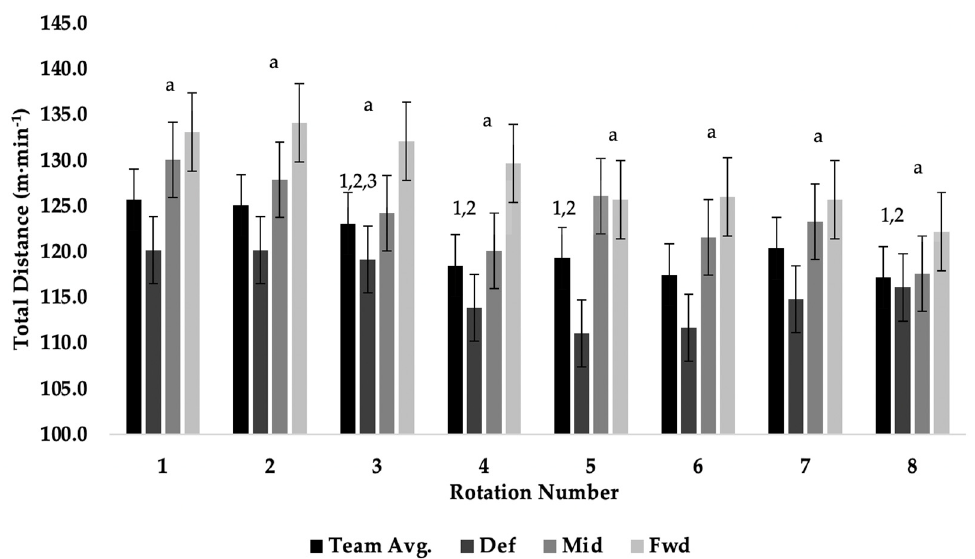
Figure 1. The average relative total distance m · min − 1 of elite female field hockey players across each rotational period during competitive match-play. The letters a, b, c signify the positional variation between the defenders ( a ), midfield ( b ) and forwards, while 1, 2, 3, 4, 5, 6, 7, 8 represent the significant difference across each rotation when compared to each other.